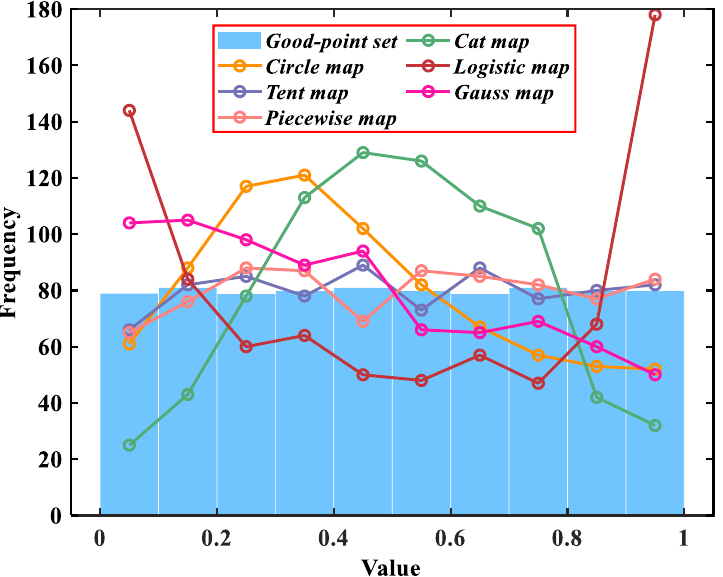
Figure 5. Average value distributions of seven different initialization strategies.